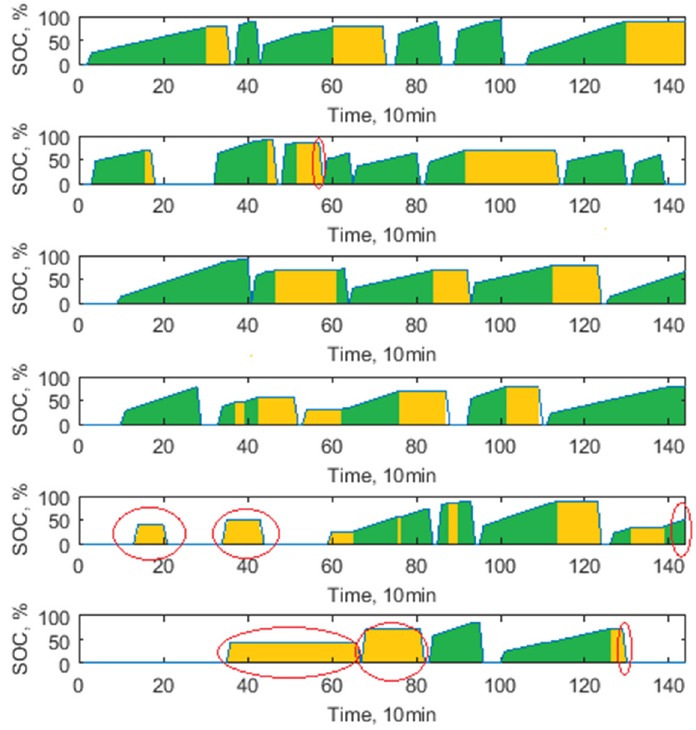
Figure 17. Changes in the SOC of freight EVs at six charging points during controlled charging (Green—EV is charging; yellow—EV is on hold; red circle— с ritical charging situations).